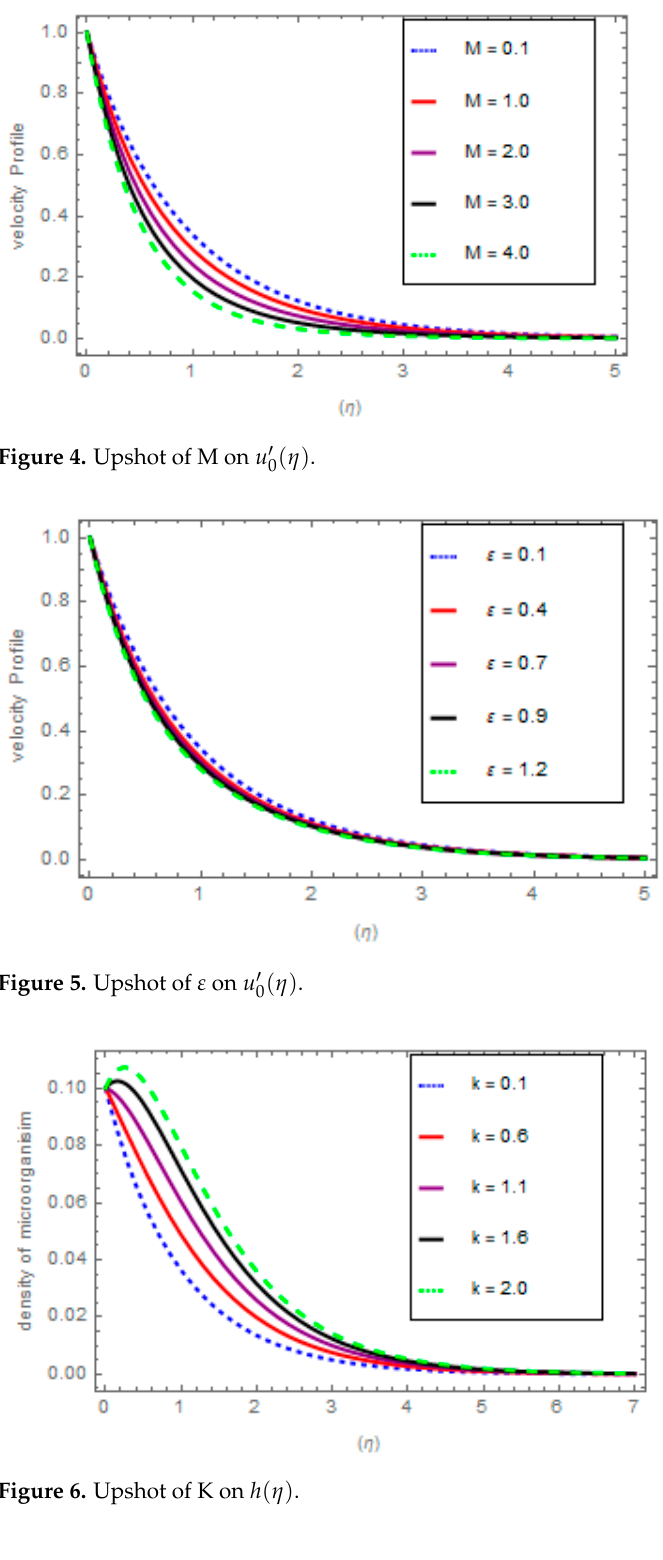
Figure 6. Upshot of K on h ( η )